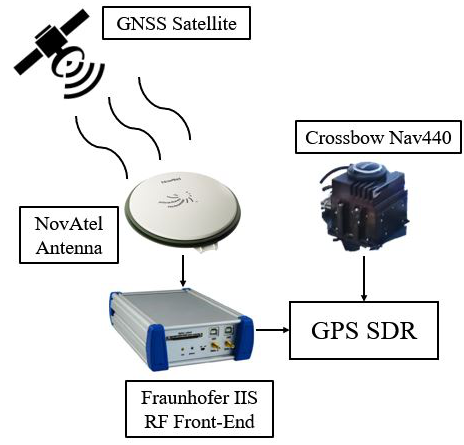
Figure 5. Setup for the stationary experiments.